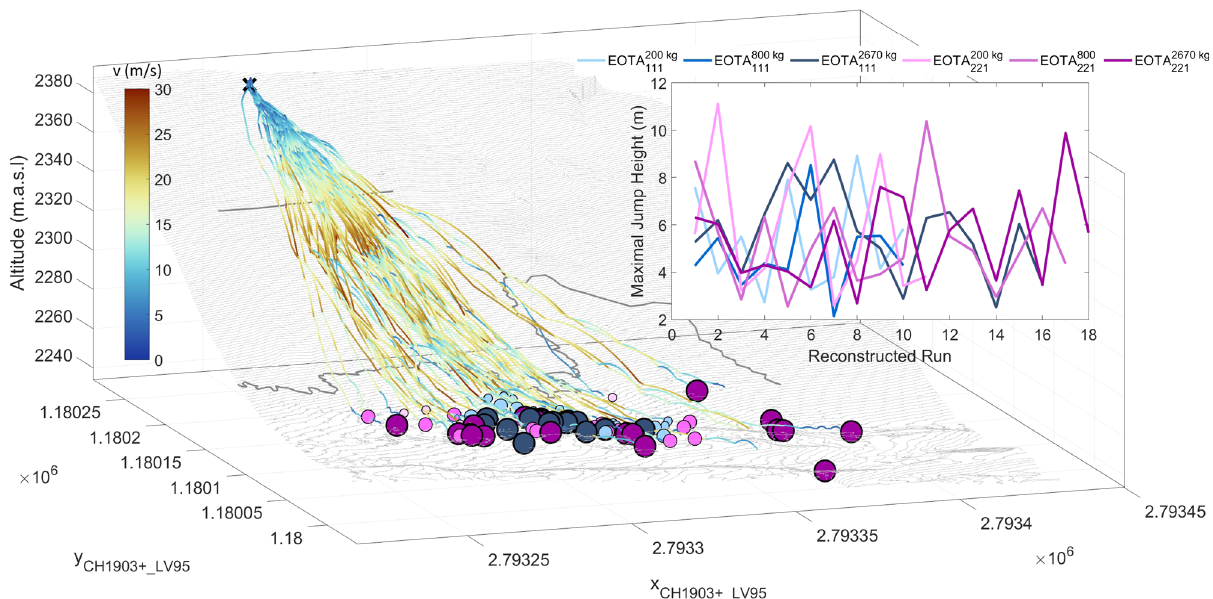
Fig. 3 Complete set of 82 reconstructed rockfall trajectories of the CSEC and their maximal jump heights. Complete set of 82 reconstructed rockfall trajectories of the CSEC. The colour and size code of the deposition points is identical to Fig. 2: Blue markers represent equant EOTA 111 rocks varying from 45 kg (light blue) to 2670 kg (dark blue). Equivalently, the wheel-shaped EOTA 221 deposition points are represented with masses from 45 kg (light magenta) to 2670kg (dark magenta). The translational kinematics are visualised with a velocity scaled, perceptually uniform, colouring 48 of the trajectories. The inset corroborates the uniform kinematic behaviour across the shape and weight classes with similar overall maximal jump heights of each trajectory usually occurring at the cliff jump (upper thick grey line) as can also be derived from similar spatial velocity distribution of the